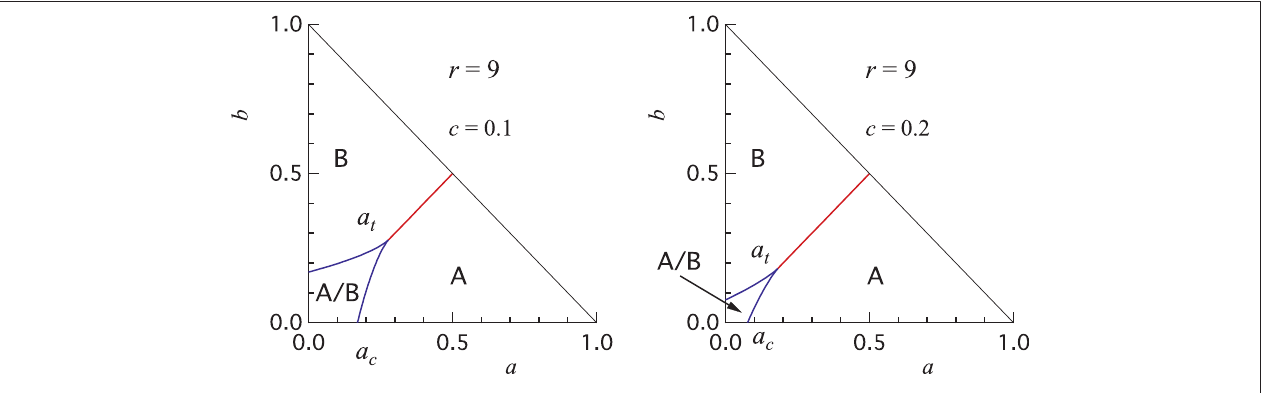
FIGURE 9 | Phase diagram on { a , b } plane for r (cid:2) 9. Left for c (cid:2) 0 . 1 and right for c (cid:2) 0 . 2. The regions marked as A , B , and A / B represent parameter values with which the system converges unconditionally to A majority, unconditionally to B majority, and to either A or B majority depending on the initial con fi guration,